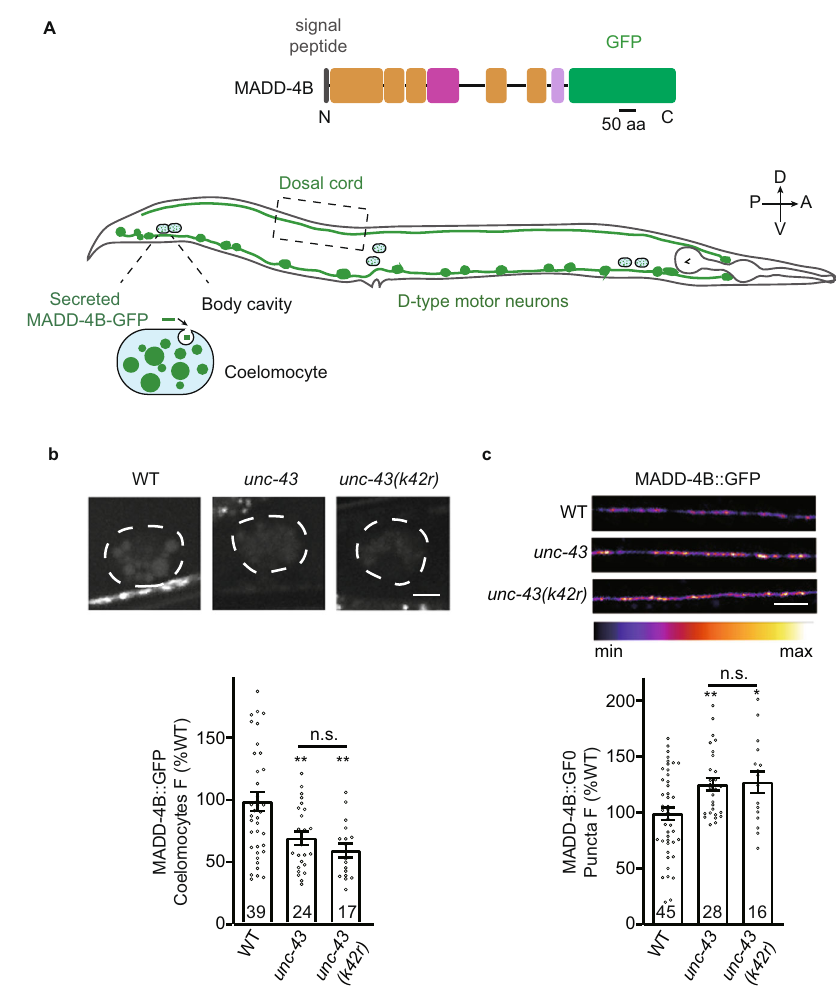
fl uorescence intensities+/ − SEM (bottom, Ns represent the number of animals tested) are shown. one-way ANOVA with post-hoc Bonferroni ’ s multiple compar- ison test. ** p <0.01, n.s. not signi fi cant. c Puncta fl uorescence of MADD-4B-GFP in thedorsalnervecordswasmeasuredinthe unc-43 mutants.Representativeimages (top, scale bar 10 μ m, Pseudo-color: Fire) and mean puncta intensities+/ − SEM (bottom, Ns represent the number of animals tested) are shown. One-way ANOVA with post-hoc Bonferroni ’ s multiple comparison test. * p <0.05, ** p <0.01, n.s. not signi fi cant. For b , c , source data are provided as a Source Data fi